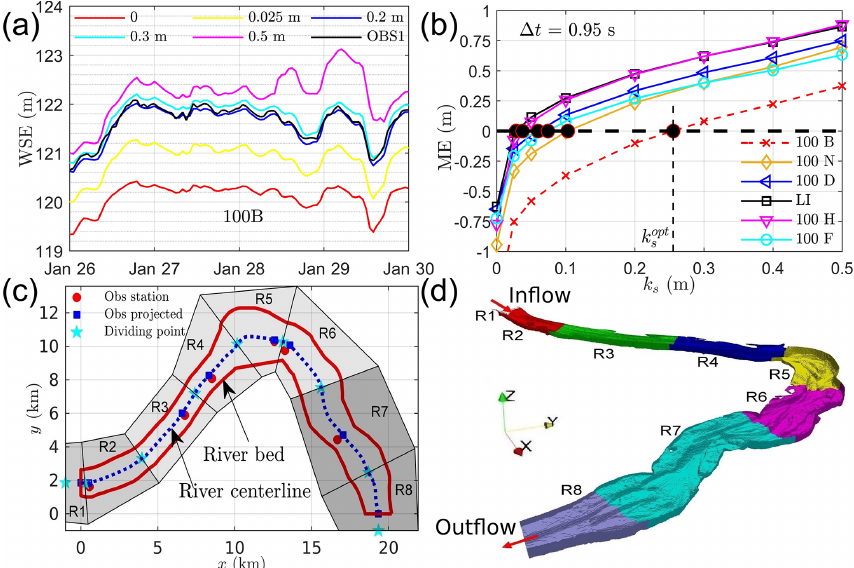
Figure 3. The effect of roughness height on WSE at a single location (a) , the ME between modeled and observed WSE at six locations (b) , the procedure of generating eight roughness regions (c) , and the 3-D view of each region represented in mesh (d)